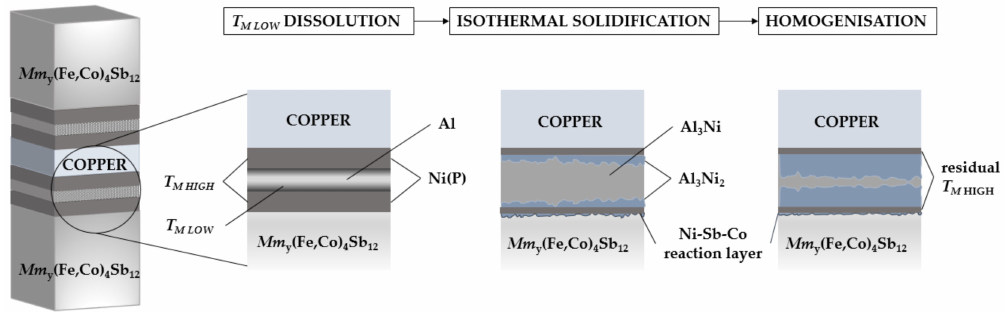
A schematic illustration of the Solid-Liquid Interdiffusion (SLID) bonding process demonstrating the interlayer configuration and joining mechanism when specimens where joined at 660 ◦ C for 4.6 min (described as “ T M LOW dissolution” and “isothermal solidification”) and when isothermally aged at 450 ◦ C for 96 h in Ar (shown as “homogenization”).